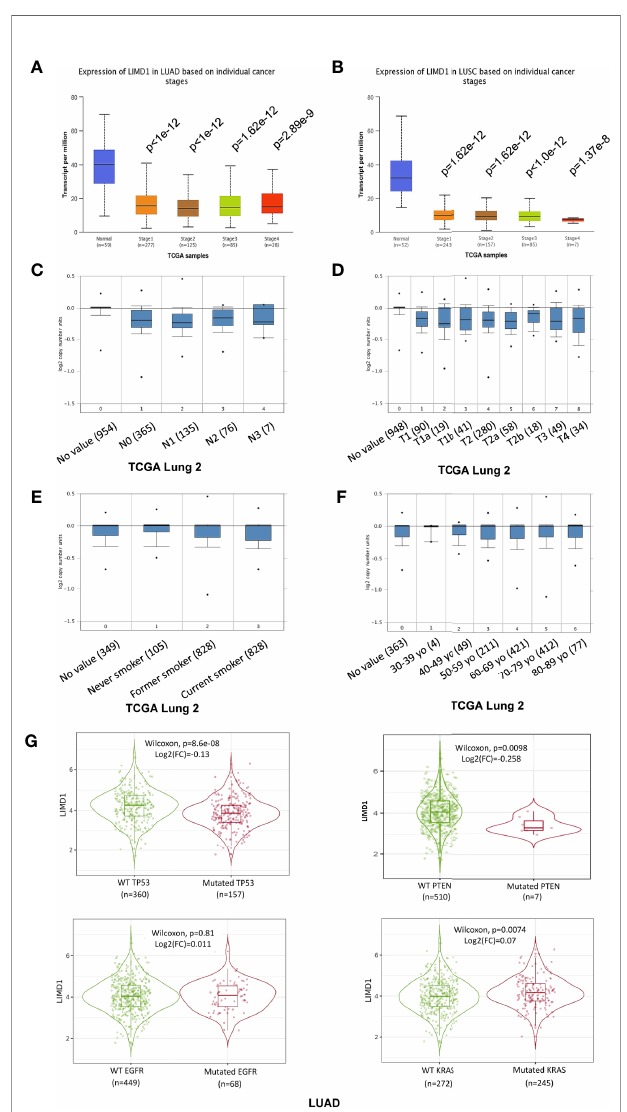
FIGURE 4 | LIMD1 differential expression patterns in lung cancer stages and its regulation by gene mutation. (A, B) LIMD1 is downregulated at the early stages of NSCLC. (C, D) Clinical stages of lung cancer have no signi fi cant differences in LIMD1 expression. (E) Smoke status has no signi fi cant effects on LIMD1 expression. (F) Ages have no signi fi cant effects on LIMD1 expression. (G) Effects of mutation of key lung cancer genes on LIMD1 expression in LUAD. (A, B) are the results from UALCAN portal, (C, F) from Oncomine, and (G) from